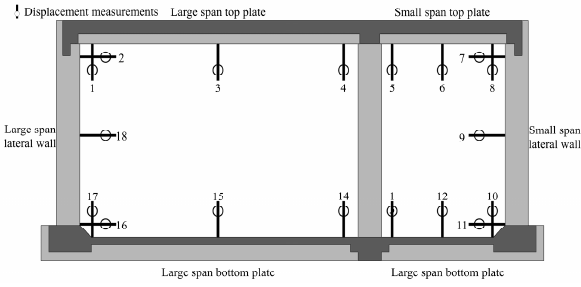
Figure 5. On-site loading of the prefabricated utility tunnel: ( a ) full-scale utility tunnel; ( b ) jack; and ( c ) displacement measurements.